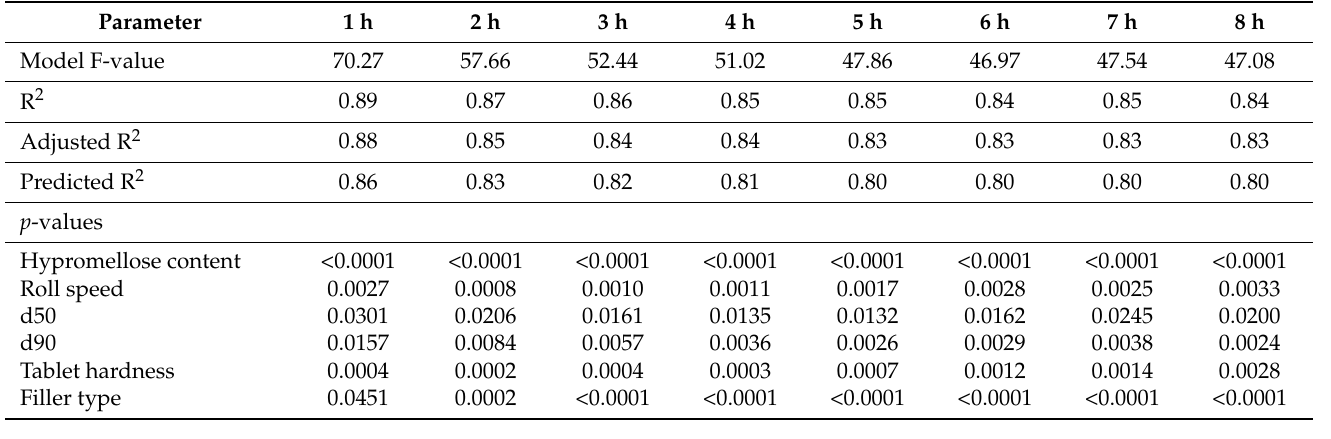
Table 2. F-value and R² values for predictive models developed at selected time points and p -values of significant factors.